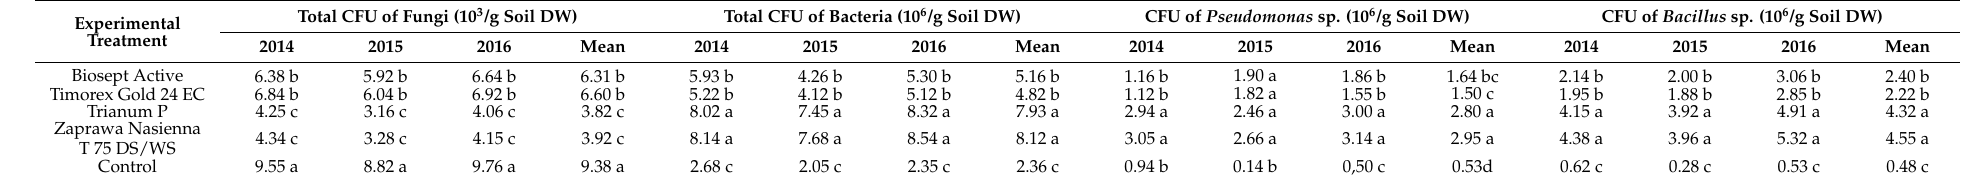
Table 4. Number of fungi and bacteria isolated from the rhizosphere of